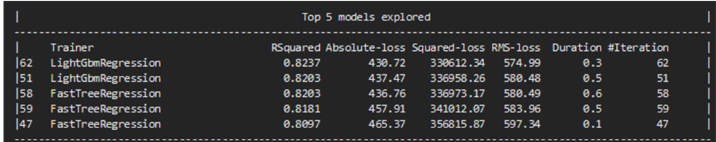
Figure 3. Training results for the flow from Italy to Greece.